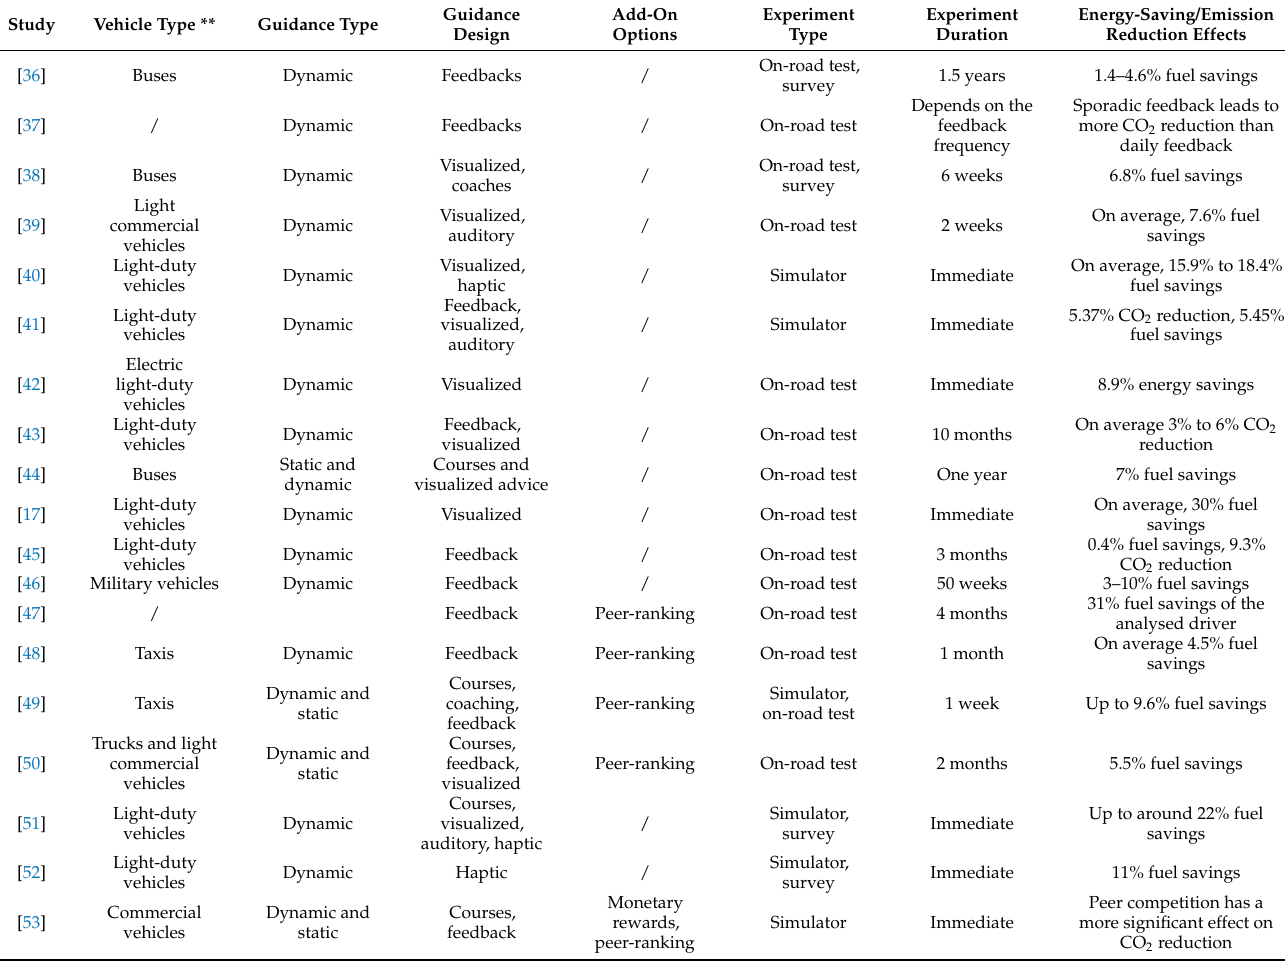
Table 2. Effects of dynamic eco-driving guidance on energy savings and emission reductions